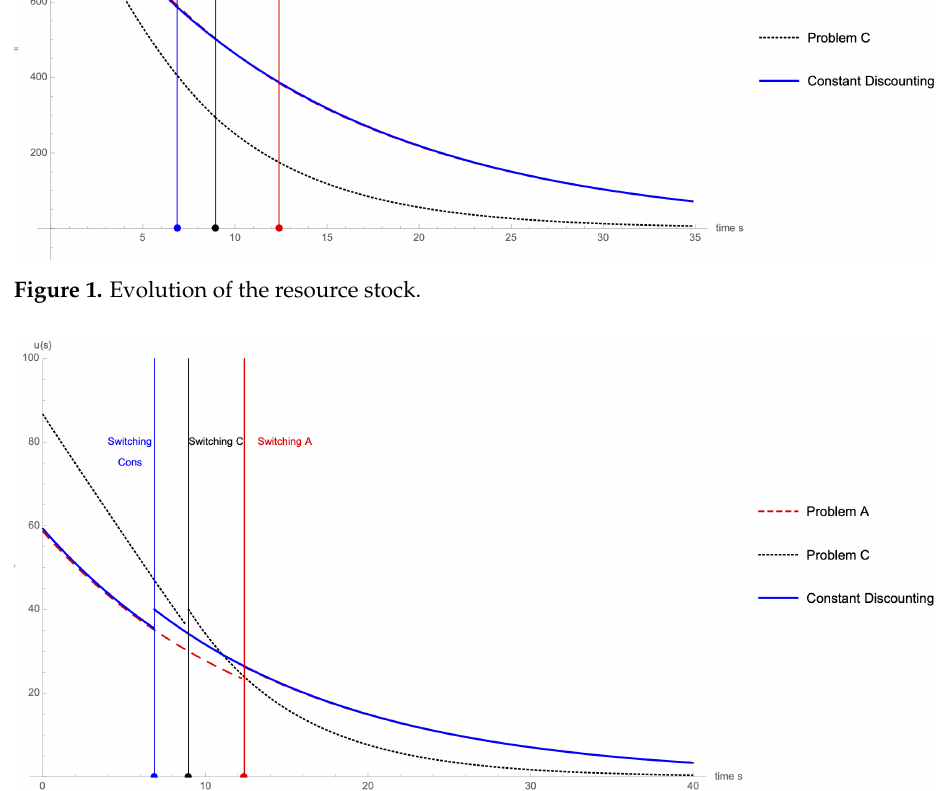
Figure 2. Evolution of the